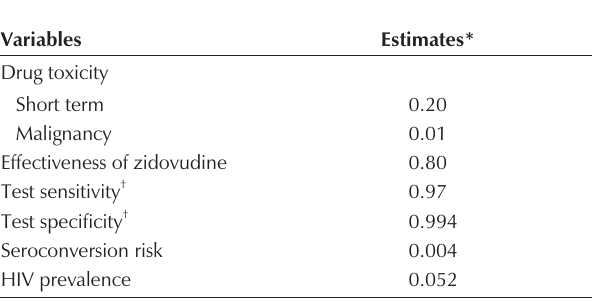
TABLE 2 Baseline probability estimates used in a decision analysis on percutaneous exposure to blood among health care